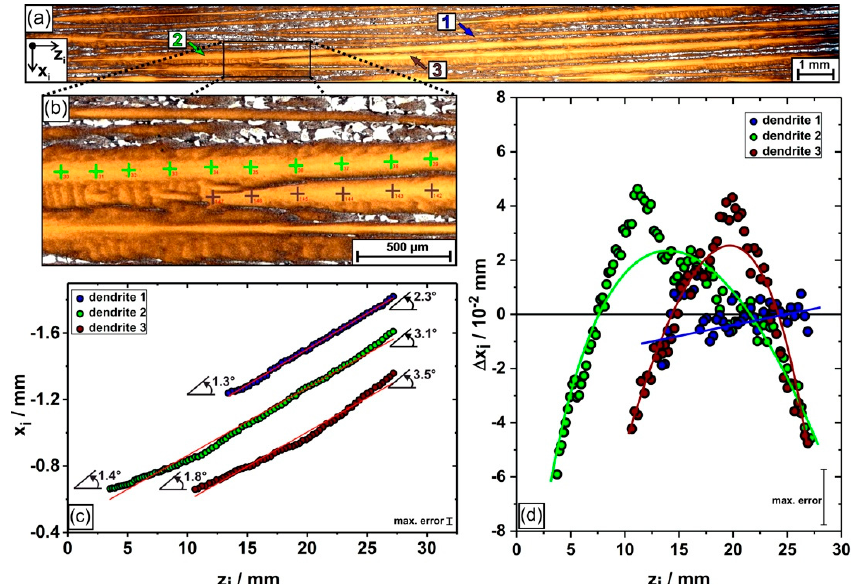
Figure 9. Evolution of scattering in dendrite orientations for seven different SX ingots along their longitudinal axes. ( a ) Standard deviation of dendrite growth direction angles δ M . ( b ) Standard deviation of angles between adjacent dendrites δ GB . The dashed vertical lines indicate the transition zone between seeds and newly grown crystals.